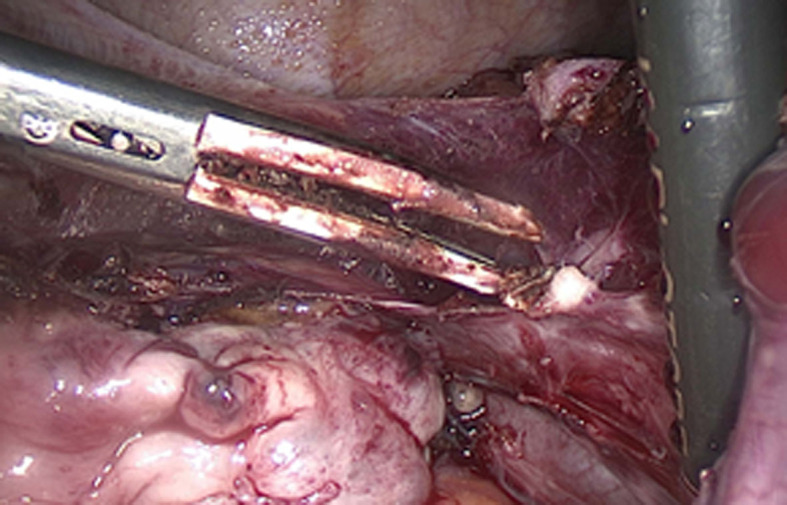
Left uterine artery.